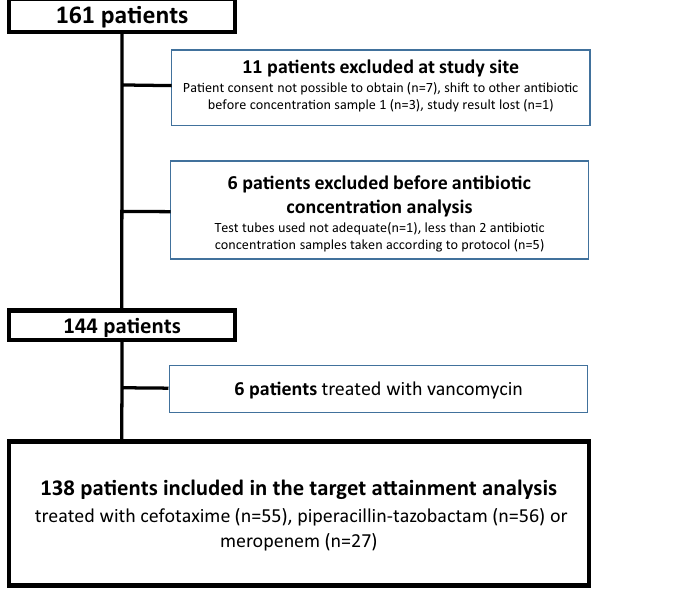
Figure 1. Flow chart illustrating the patients in the